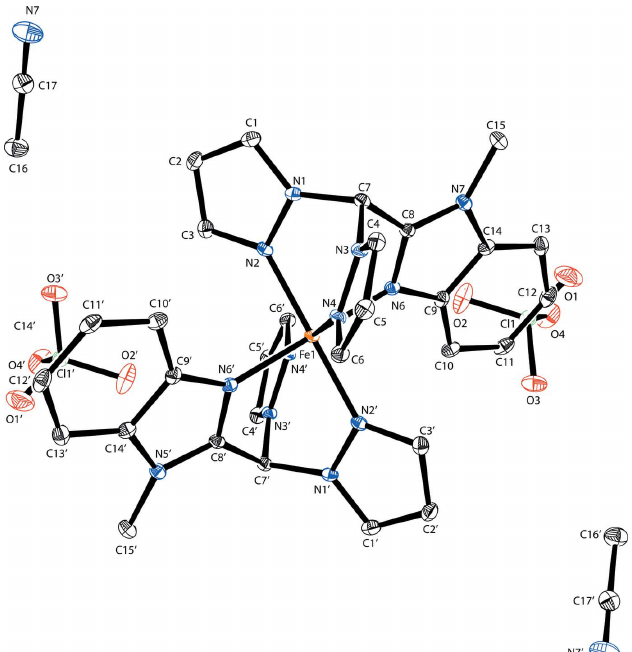
Figure 1 The molecular structure of the title compound, showing the atom- labelling scheme and displacement ellipsoids at the 40% probability level for non-H atoms. H atoms are omitted for the sake of clarity. [Symmetry code: ( 0 ) (cid:5) x + 1, (cid:5) y + 1, (cid:5) z + 1.].